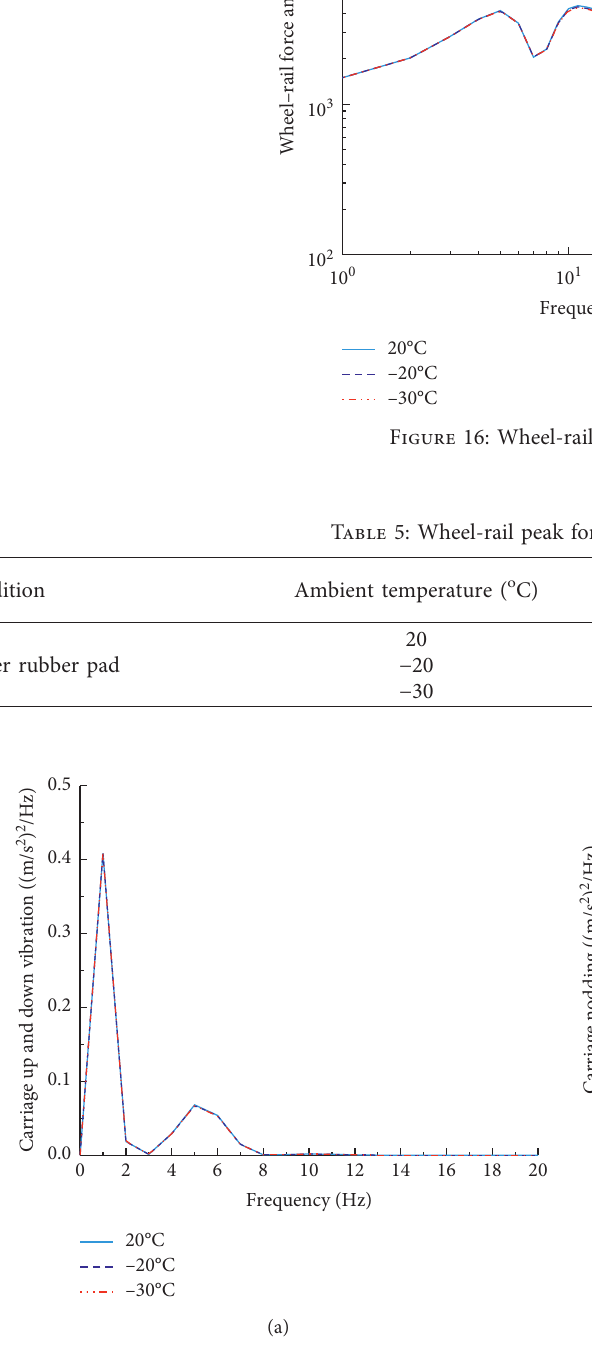
Figure 17: Power spectrum of vehicle body vibration acceleration when (a) carriage up and down vibration and (b) carriage